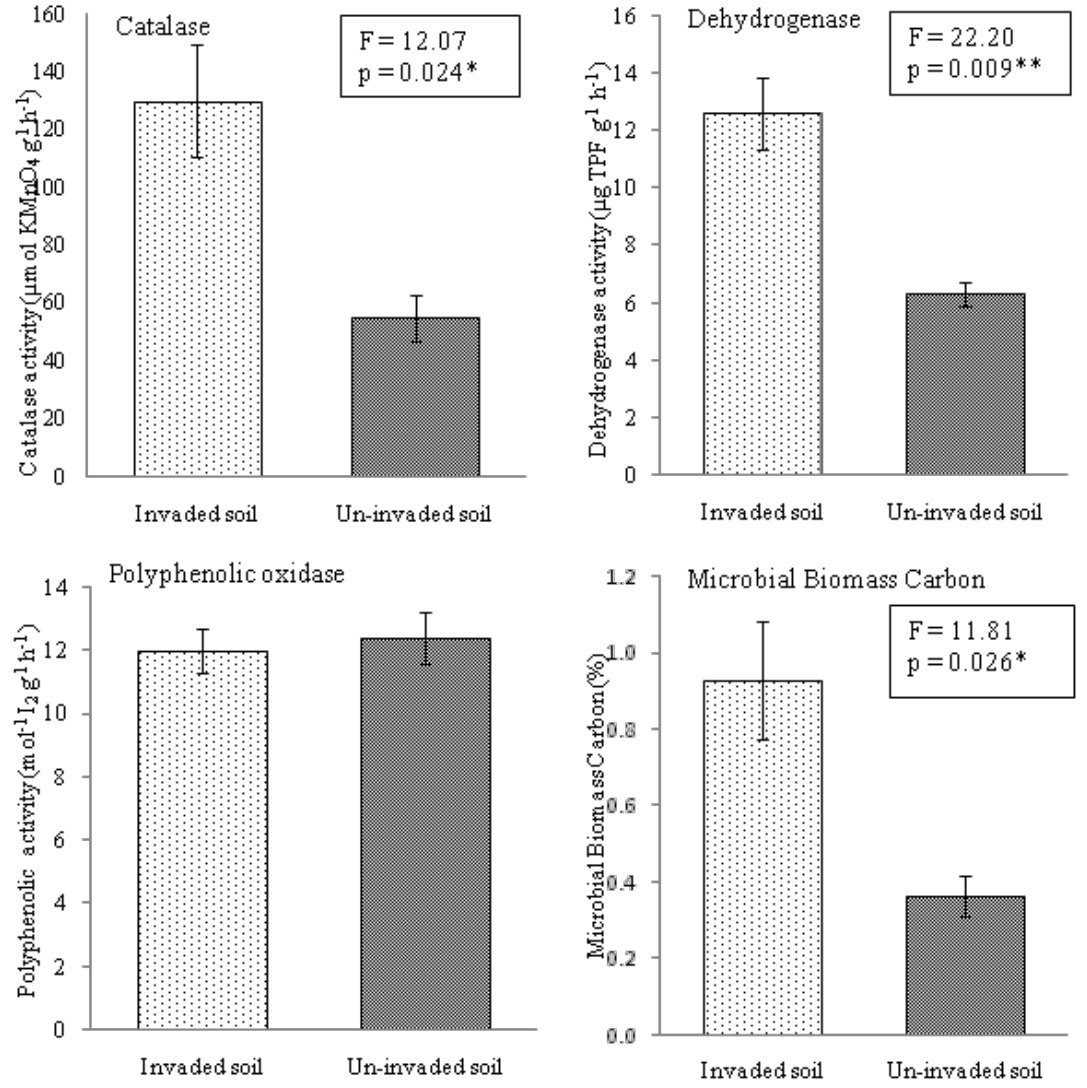
Figure 5: Enzyme activities (catalase, dehydrogenase and polyphenolic oxidase) and microbial biomass carbon (%) in Austroeupatorium invaded soil and un-invaded soils. The means are averages of 3 composite samples. Error bars indicate standard error of the mean (SEM)